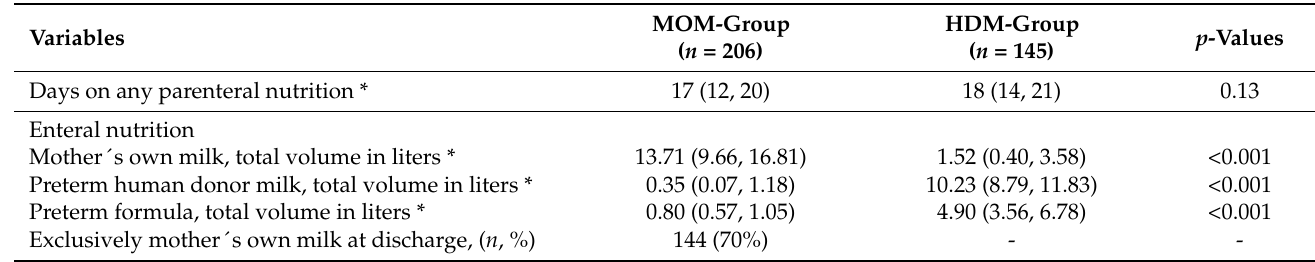
Table 2. Parameters of enteral and parenteral nutrition.